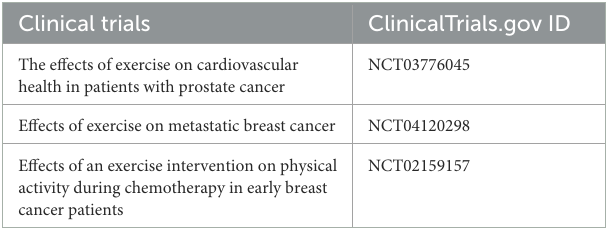
TABLE 2 Clinical trialsfor revealing relevant mechanisms in